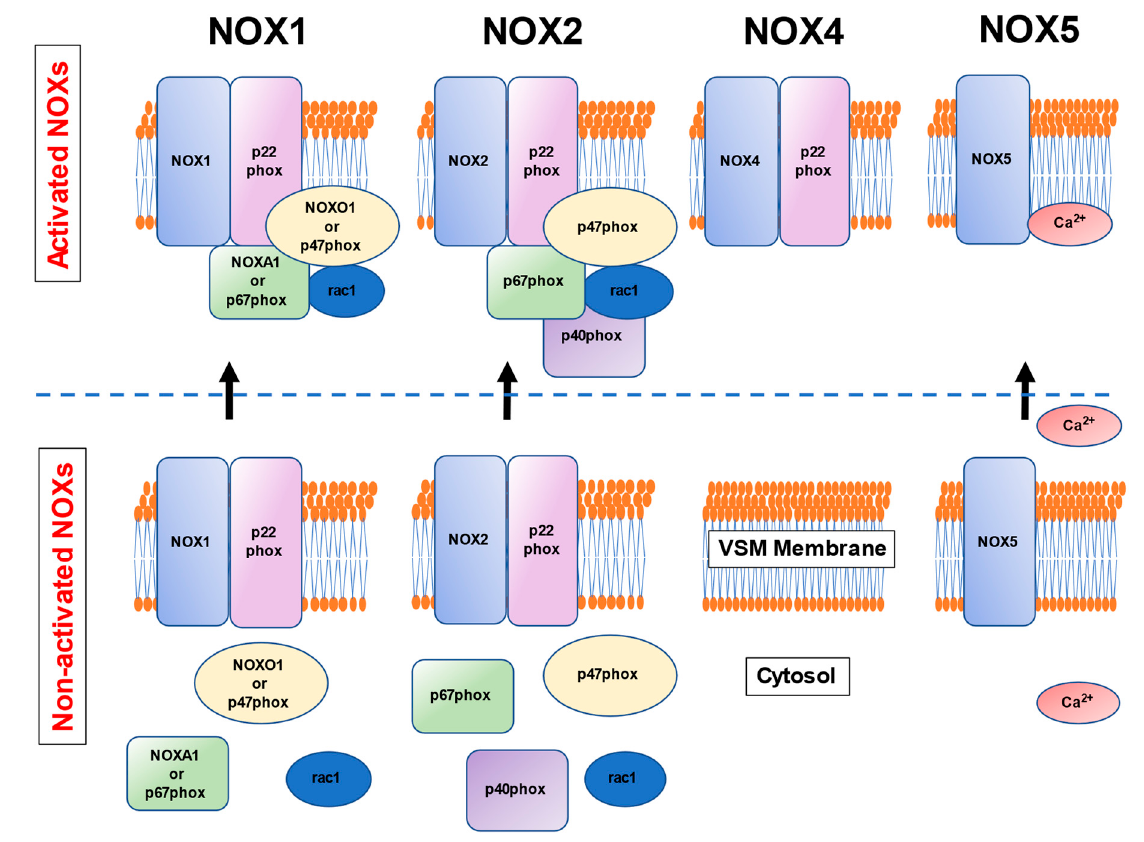
Figure 2. NOX 1, 2, 4, and 5 are expressed in human vascular smooth muscle cells. NOX1, 2, and 4 have the transmembrane subunit p22phox both in the active and inactive forms. NOX1 interacts with the cytosolic subunits NOXO1 or p47phox, NOXA1 or p67phox, and rac1 upon activation. NOX2 activates when it is associated with p47phox, p67phox, p40phox, and rac1. NOX4 is constitutively activated with the cytosolic p22phox subunit. NOX5 needs Ca 2+ binding in the cytosol for activation.